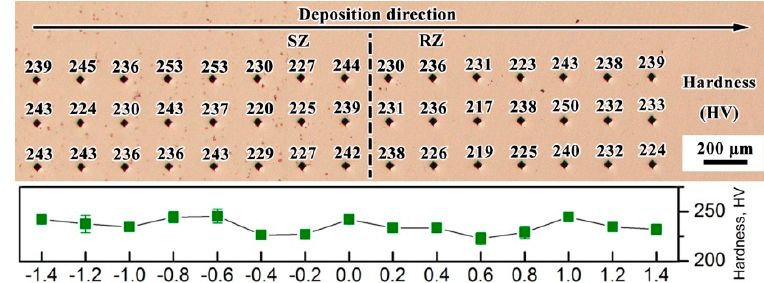
Figure 14. Vickers hardness values of the LARed Inconel 625 alloy sample.